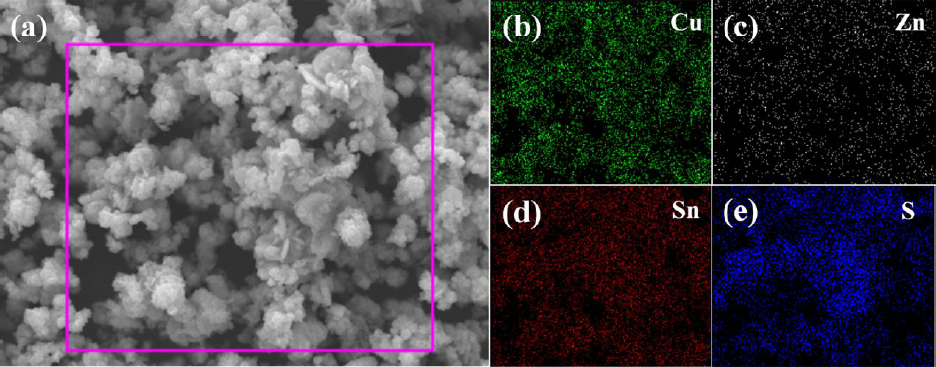
Figure 4. ( a ) SEM image of CZTS-24 h sample and the corresponding elemental mapping of ( b ) Cu, ( c ) Zn, ( d ) Sn, and ( e ) S.